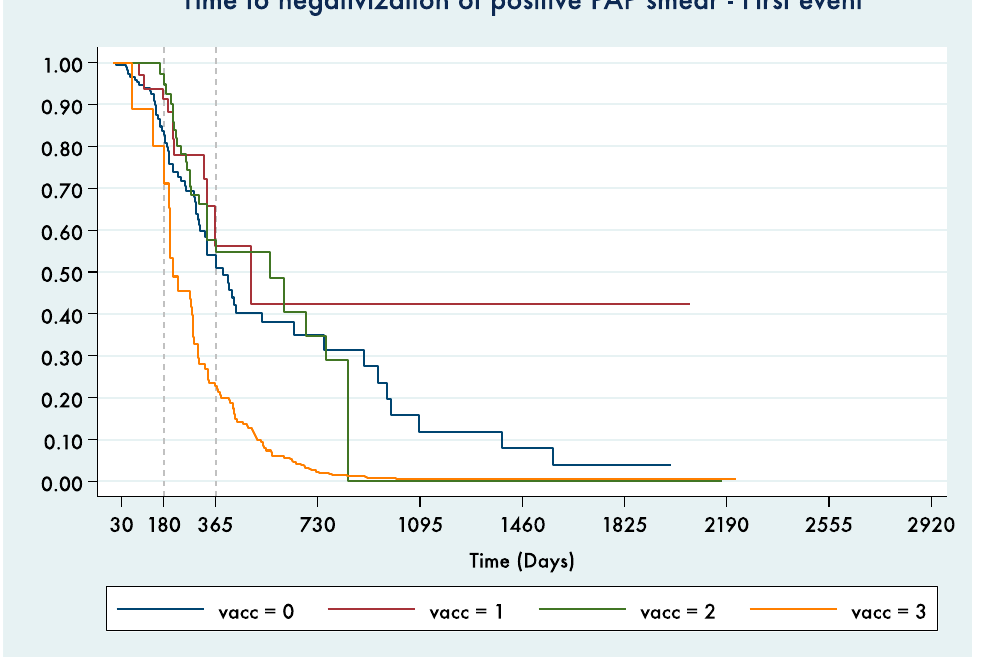
Figure 3. Kaplan–Meier curve for time to negativization of a positive Pap smear. Only the time to the 1st negative Pap smear after a positive Pap smear was considered (0—before vaccination, 1—exposed to 1st dose, 2—exposed to 1st and 2nd dose, 3—exposed to all 3 doses).